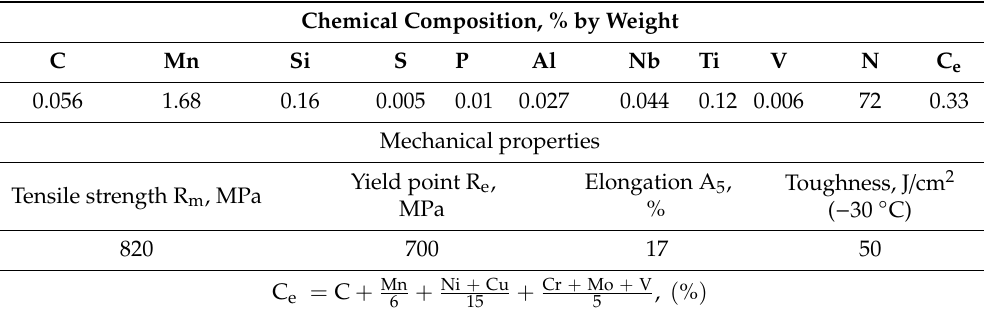
Table 1. Actual chemical composition of S700MC steel.